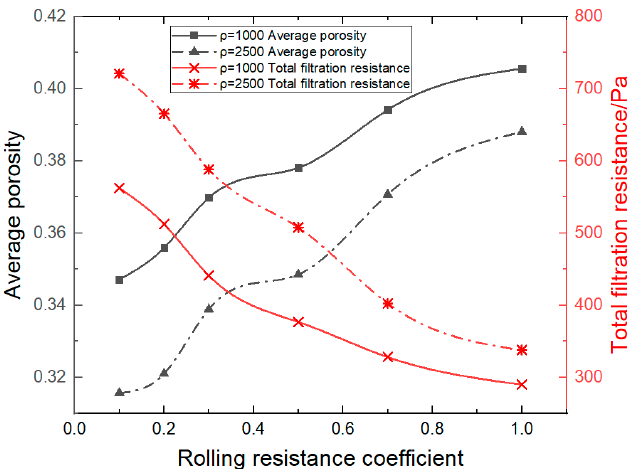
Figure 6. Effect of rolling resistance coefficient on average porosity and total filtration resistance of filter cake. Table 2. Relationship between the equilibrium moisture regain and relative humidity of particles.